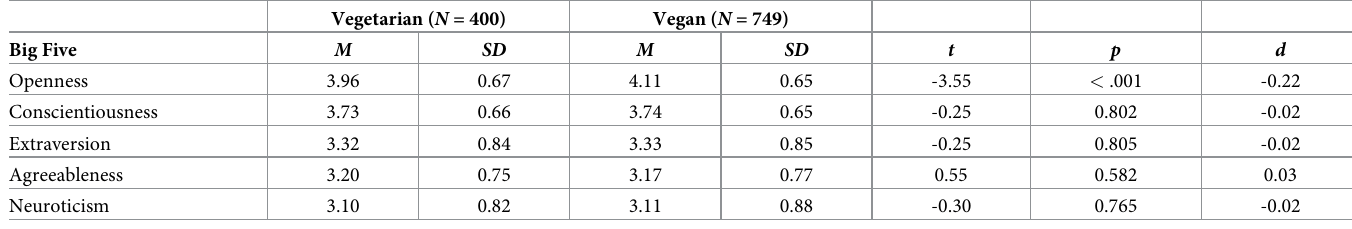
Table 1. Pre-study: Big five personality traits as a function of eating